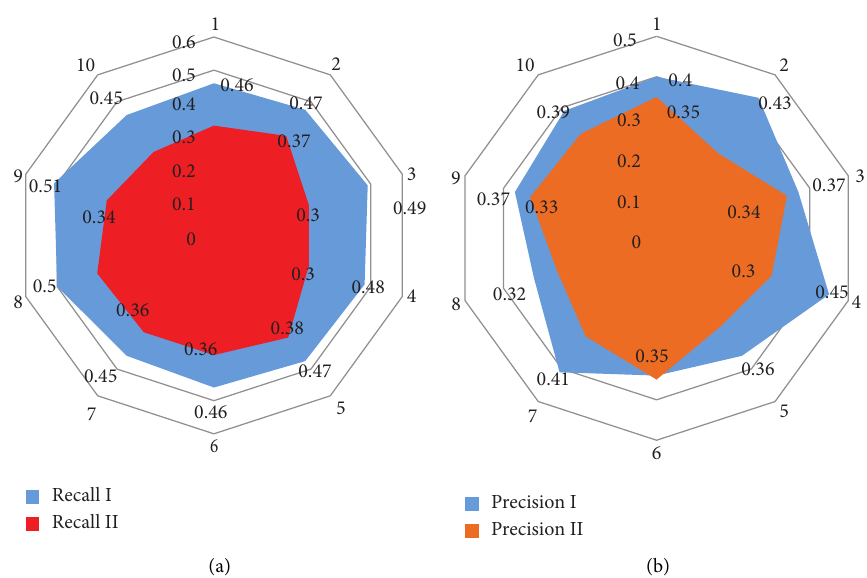
Figure 9: Comparison of recall and accuracy of two waterfall fusion algorithms. (a) Recall comparison. (b) Accuracy